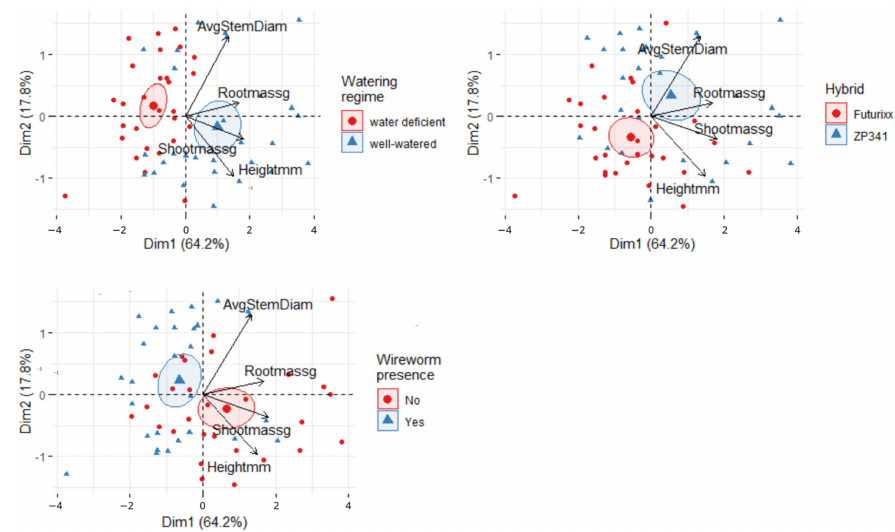
Figure 7. Morphological characterisation by principal component analysis (PCA) for overall com- parison of maize plants of different hybrids (ZP341 vs. FuturiXX), under different watering regimes (well-watered vs. water-deficient) and subjected to herbivory (no wireworms vs. wireworm-infested). The first axis (Dim1) explains 64.2% of the accumulated variance, and the second axis (Dim2) explains 17.8% of accumulated variance.